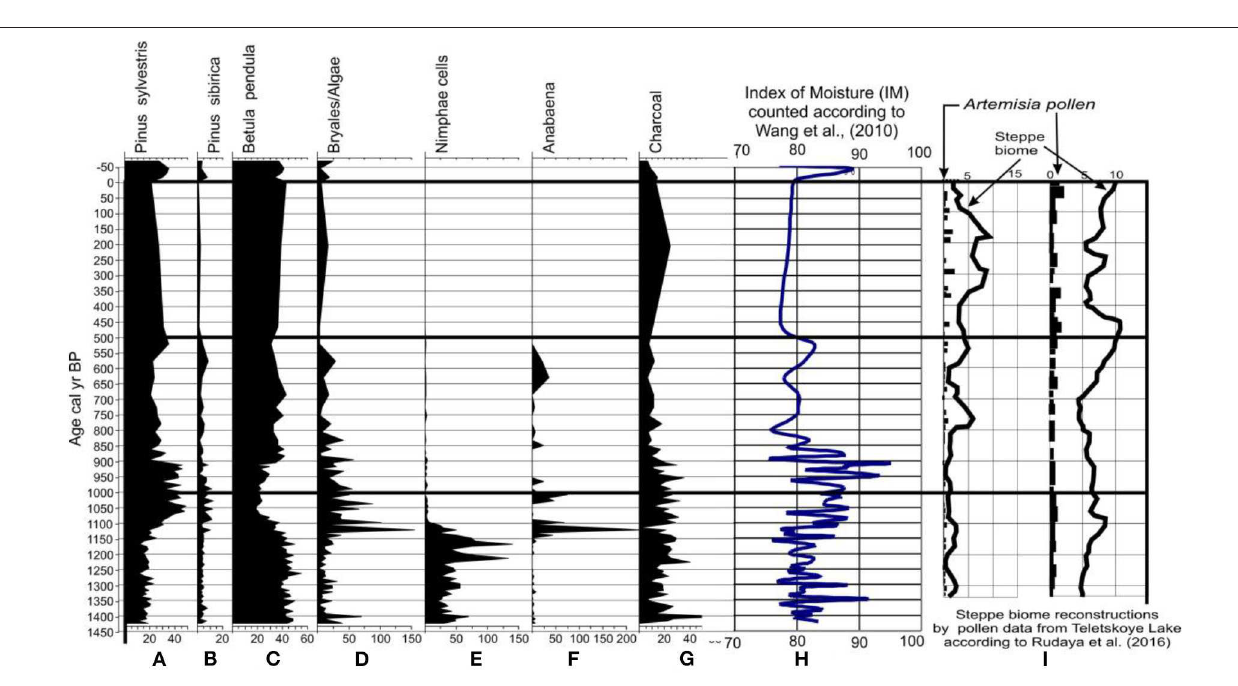
FIGURE 6 | Diagnostic palynomophs of Manzherok Lake and the pollen-based index of humidity of the climate from this study compared with the content of diagnostic Artemisia pollen and steppe biome reconstructions in the neighboring Teletskoye Lake (Rudaya et al., 2016). ( A-I ) indicator pollen types and indices based on